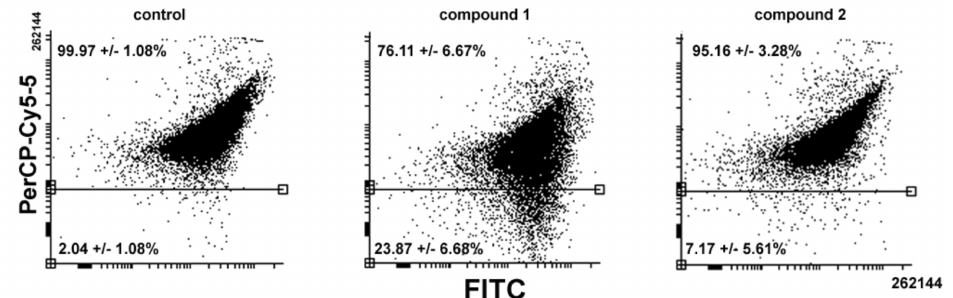
Figure 5. Representative flow cytometric analyses of AVO accumulation in MDA-MB-231 cells cultured in control conditions or exposed to either 1 or 2 for 24 h. The percentage indicated in the top quadrants refers to AVO-positive cells. The dot plots show the result of a representative experiment. The results are expressed as the mean ± SEM of triplicate